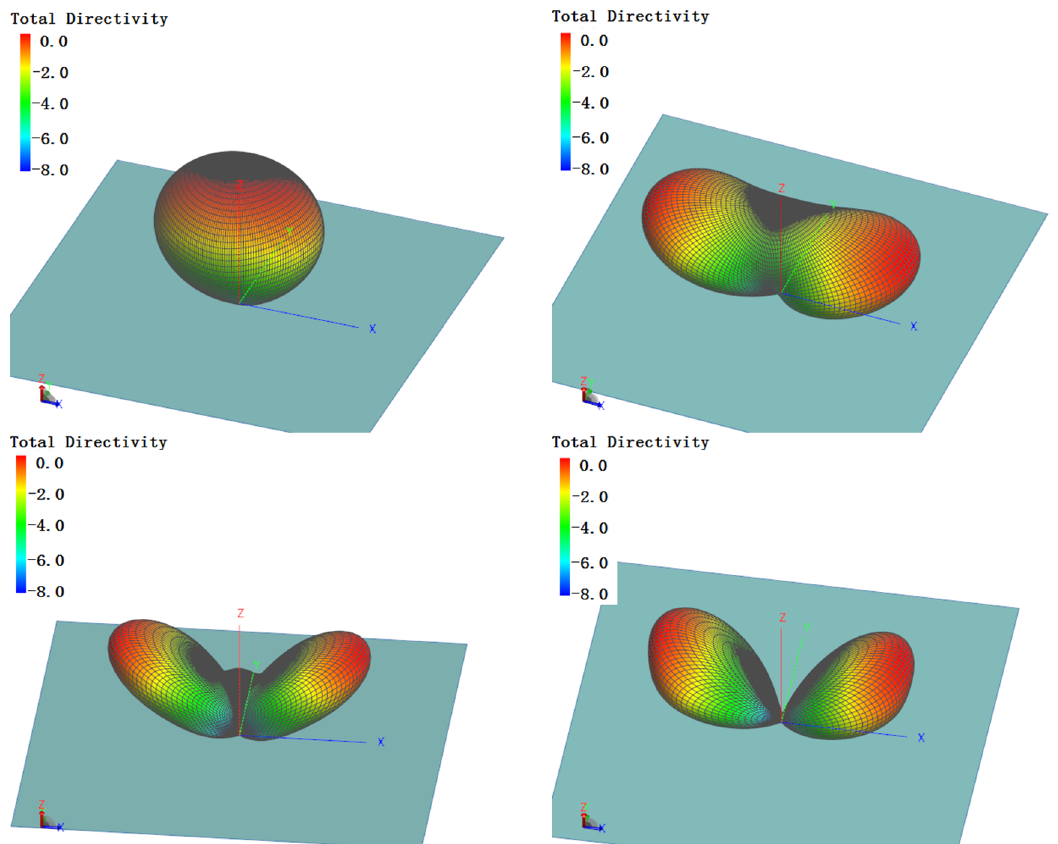
Figure 7. 3D pattern of the miniaturized antenna.